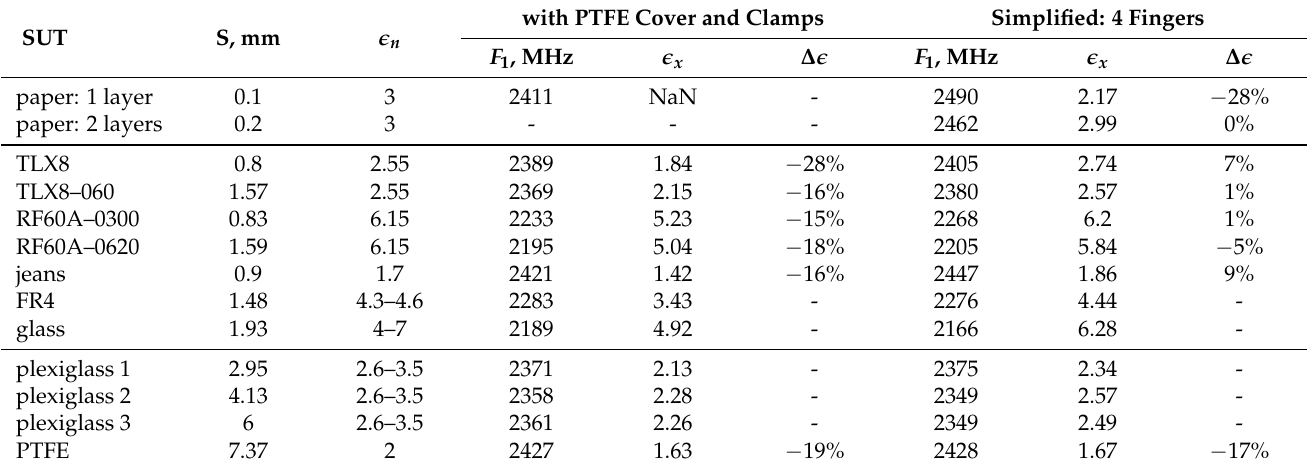
Table 8. Result comparison: a “simplified” vs. the “original” configuration.